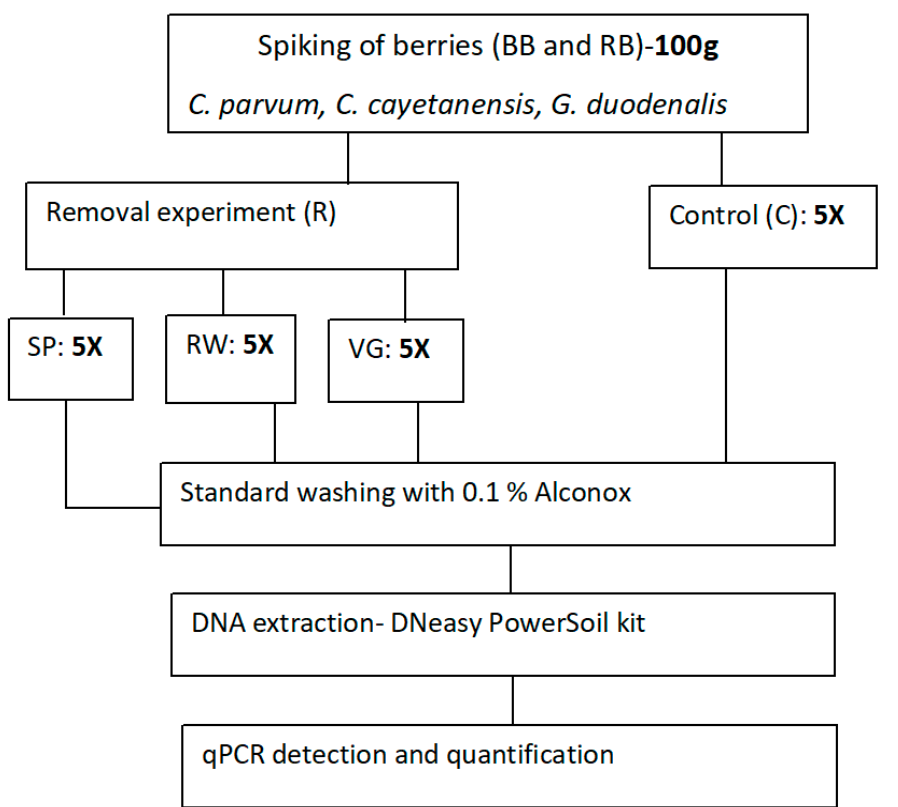
Figure 1. The experimental design for comparative evaluation of the removal efficiency of 3 methods for washing berries prior to consumption. Key: BB—blueberry, RB—raspberry, RW—running water, VG—vinegar, SP—salad spinner.